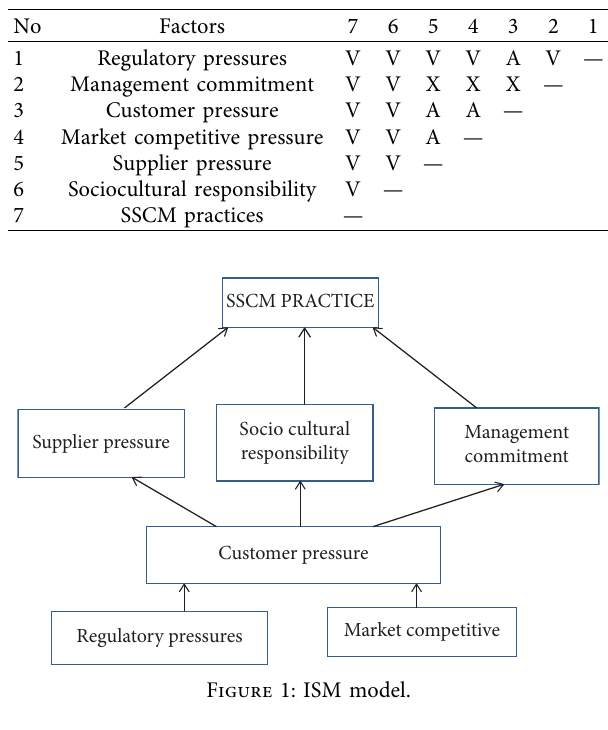
Table 1: Structural self-interaction matrix.